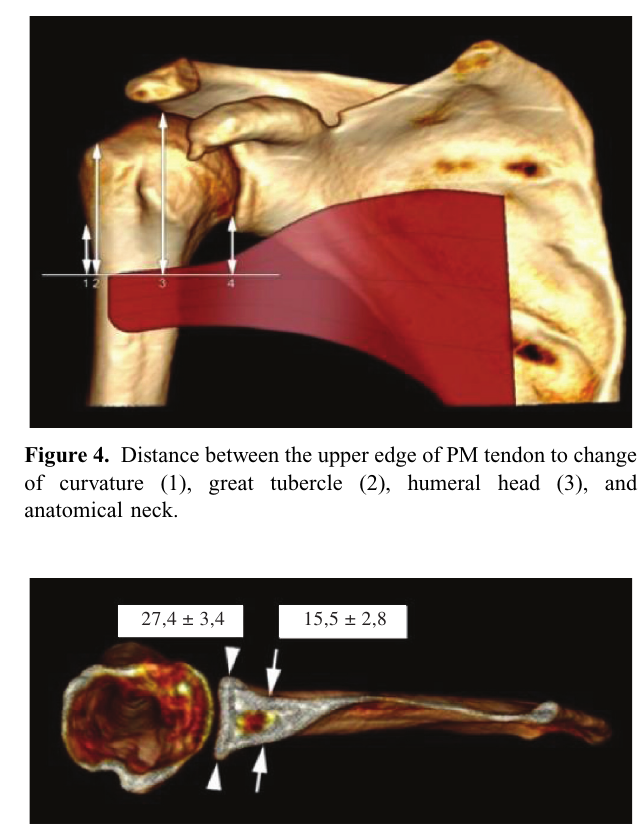
Figure 5. Mean values ± SDs for maximum and minimum